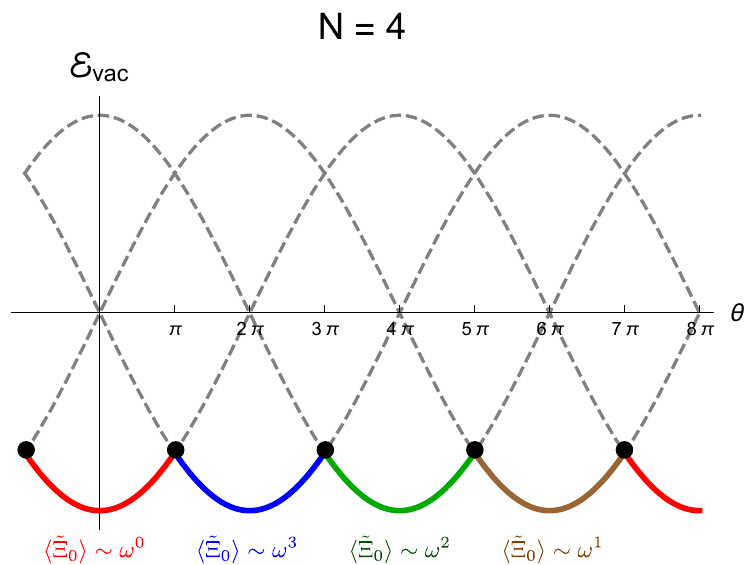
Figure 1 . [Color Online.] An sketch of the phase structure of SU( N ) YM theory for N = 4 as a function of (cid:18) . The vertical axis depicts the vacuum energy density. The gray dashed curves indicate the energy density associated with the four distinct (cid:18) -extrema. The colored bold curves indicate the vacuum energy density associated with the thermodynamically stable vacuum branch for any given (cid:18) . The black dots at the cusps label the locations of quantum phase transitions. These phase transitions are associated with changes in the expectation values of GNO ’t Hooft magnetic holonomies, as discussed in the main